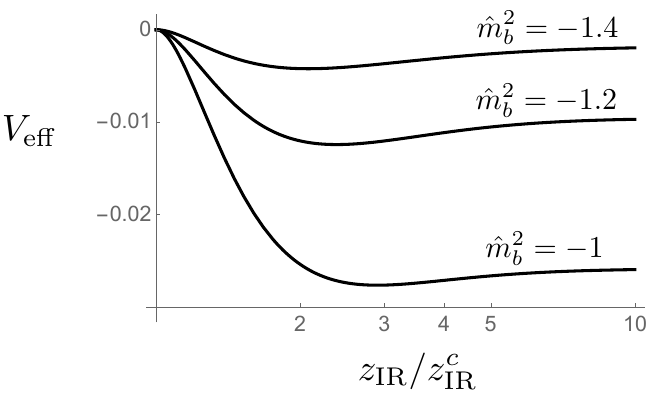
Figure 4 . Dilaton e(cid:11)ective potential for (cid:21) = 1, ^ (cid:20) 2 = 0, (cid:14) ^(cid:3) = 0 and di(cid:11)erent values of ^ m 2